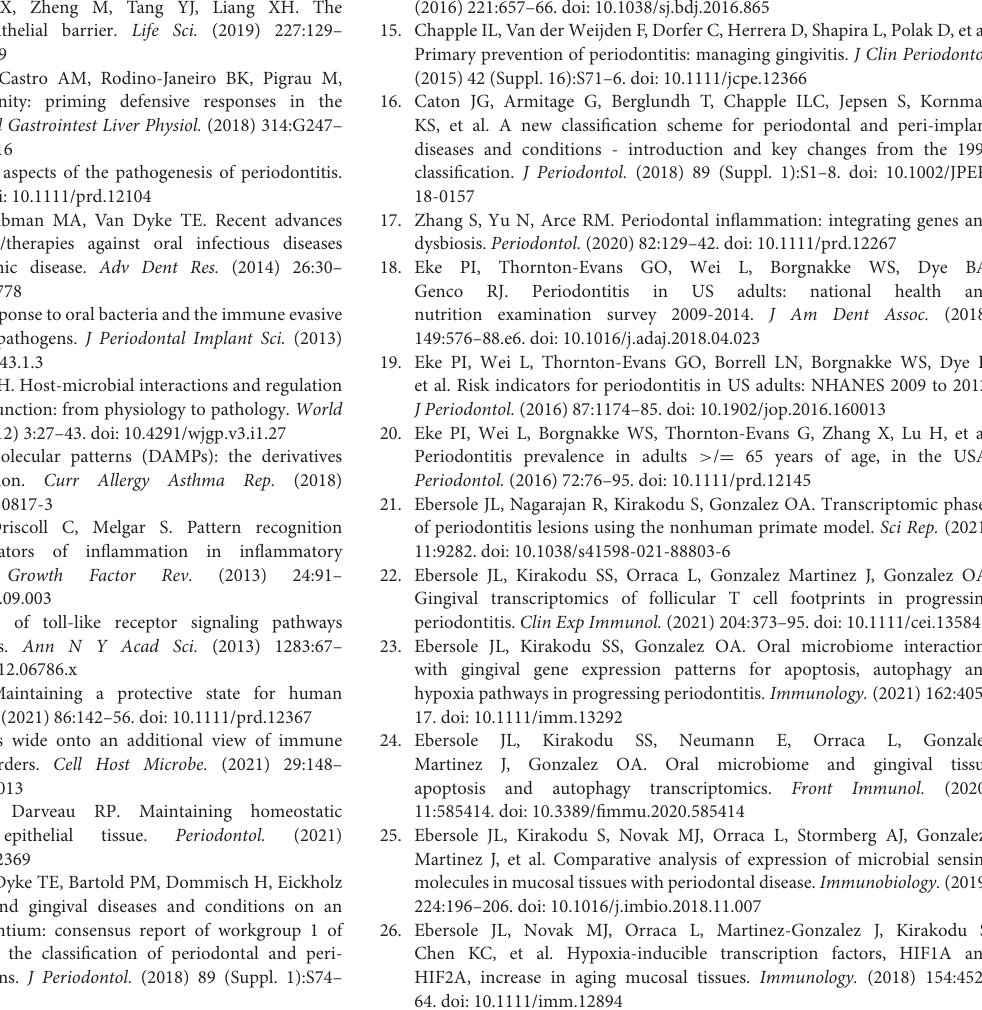
Supplementary Figure 1 | (A–G) Normalized gene expression levels in gingival tissues reflecting epithelium/epithelial cell functions. The points represent the